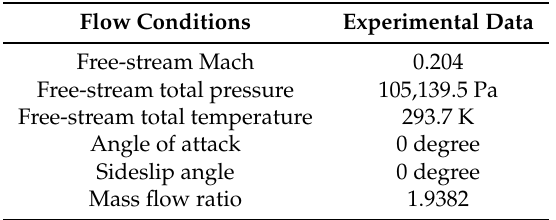
Table 1. Flow conditions of the DP78 run of RAE-M2129